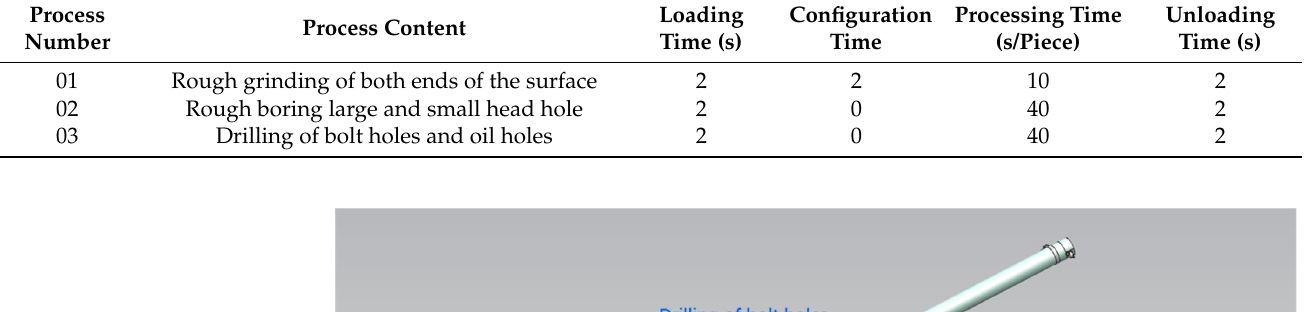
Table 3. The process table of the first part of the processing area.